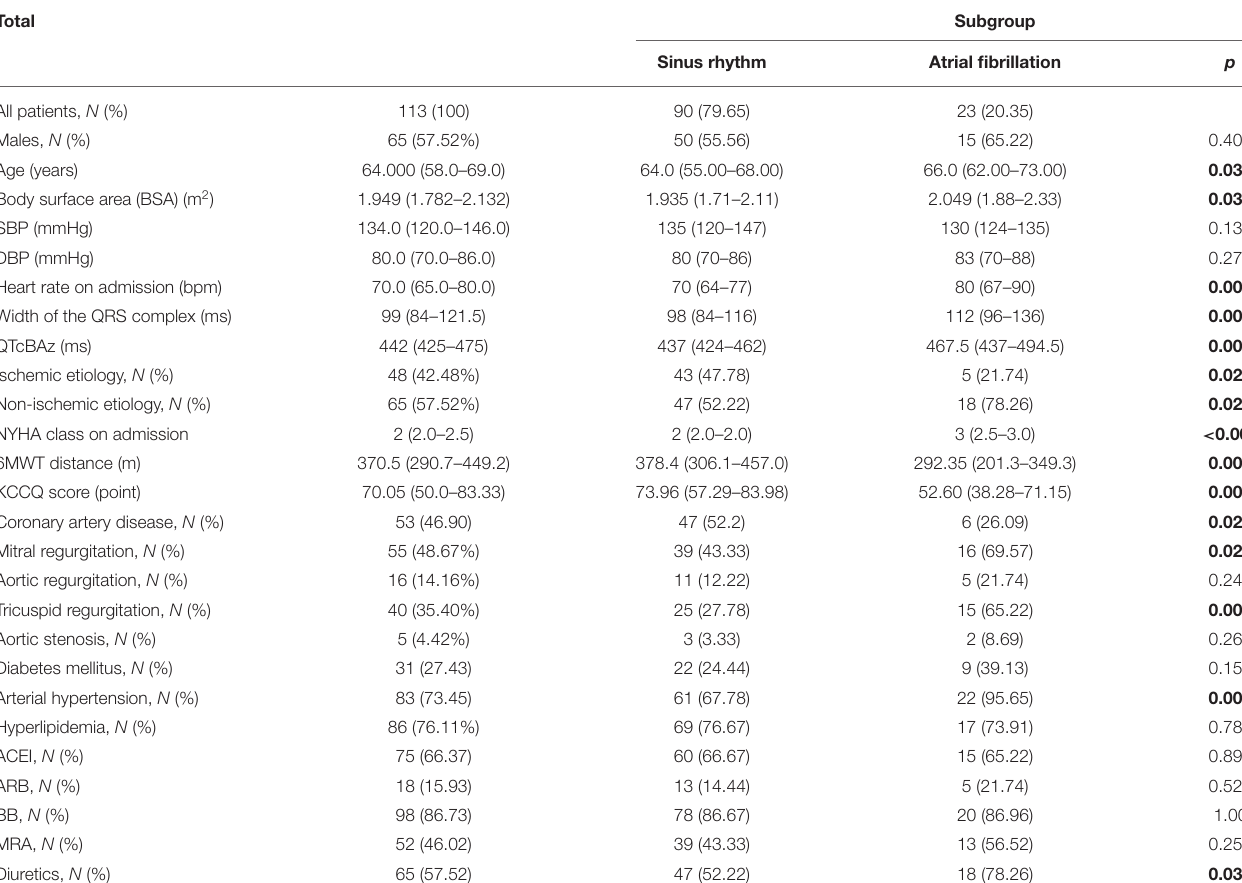
TABLE 1 | General characteristics of study groups divided according to cardiac rhythm.